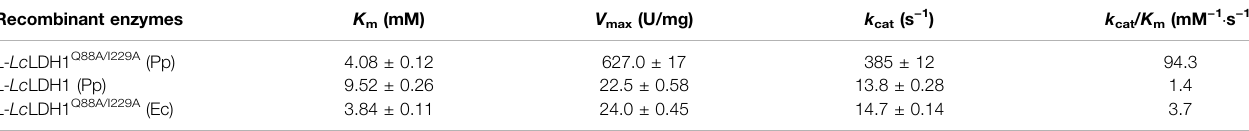
TABLE 2 | The kinetic parameters of the recombinant enzymes. Recombinant enzymes